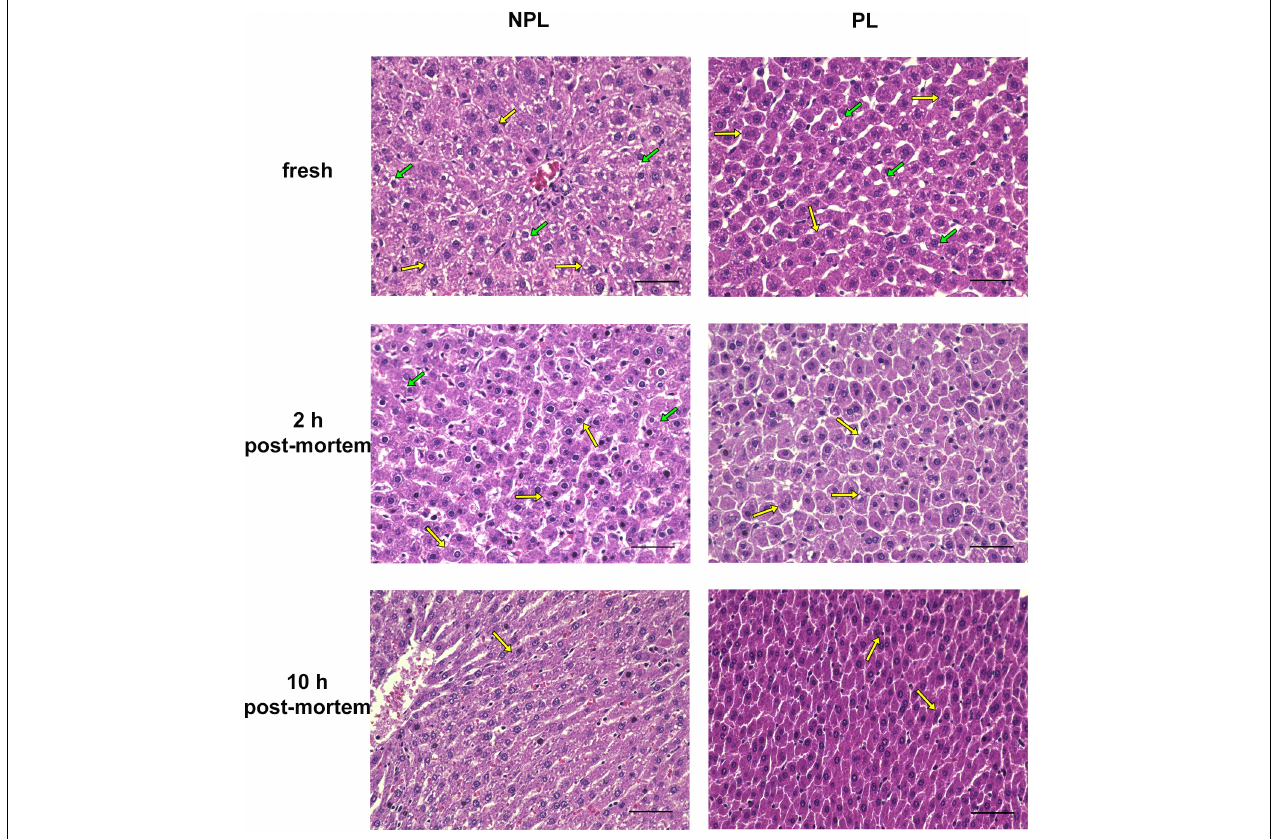
FIGURE 4 | Representative H&E-stained liver sections from NPLs and PLs collected immediately after death (fresh), 2 h post-mortem, and 10 h post-mortem. Scale bars correspond to 50 µ m. NPL, non-perfused liver; PL, perfused liver. Arrows indicate examples for: glycogen (green) and cell wall (yellow).